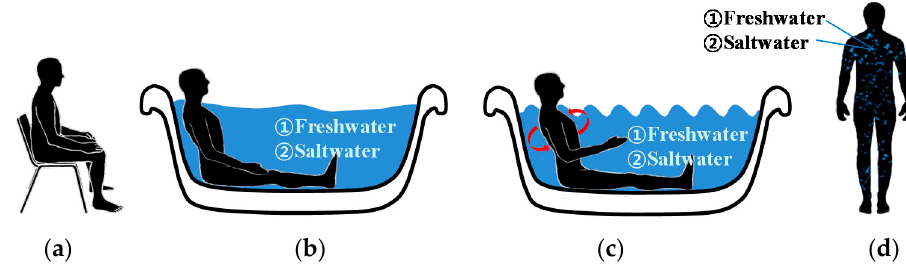
Figure 5. Experimental protocol for electrocardiogram data acquisition: ( a ) dry condition; immersed condition: ( b ) without movement; and ( c ) side-to-side movement; and ( d ) wet condition. HRV was measured in both time and frequency domains [45]. Time domain analysis included mean normal-to-normal (NN) interval (meanNN), standard deviation of all NN intervals (SDNN), the root mean square of the differences between adjacent NN intervals (RMSSD) and number of pairs of adjacent NN intervals differing by more than 50 ms in the entire recording (NN50). Frequency domain HRV analysis included low frequency (LF, 0.04–0.15 Hz), high frequency (HF, 0.15–0.4 Hz) bands, total power, and HF/LF